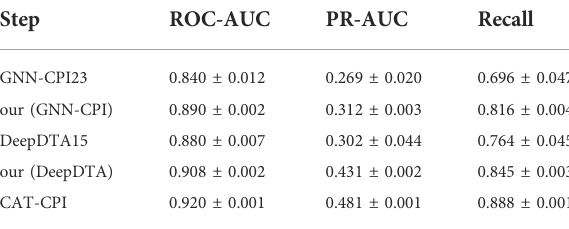
TABLE 7 Network component ablation experiments on Davis dataset.